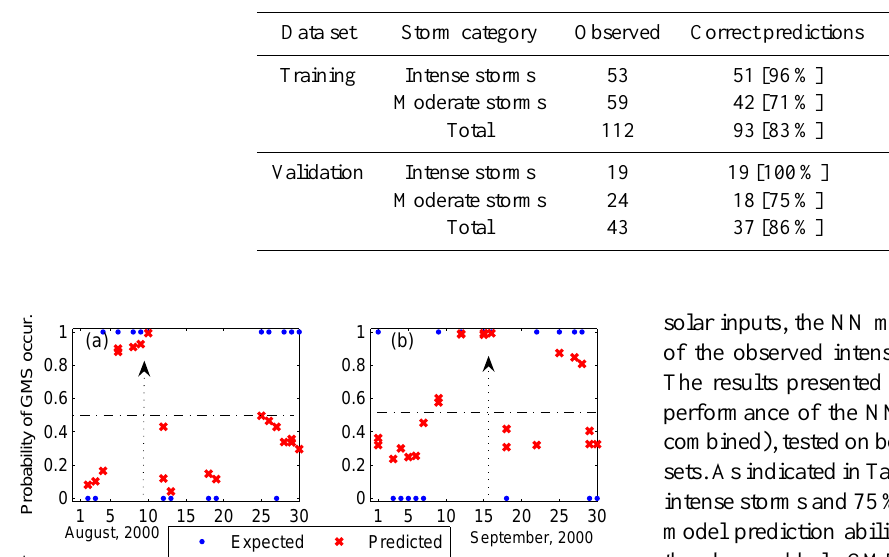
Table 4. Prediction performance of the NN model on both the training and validation data sets.